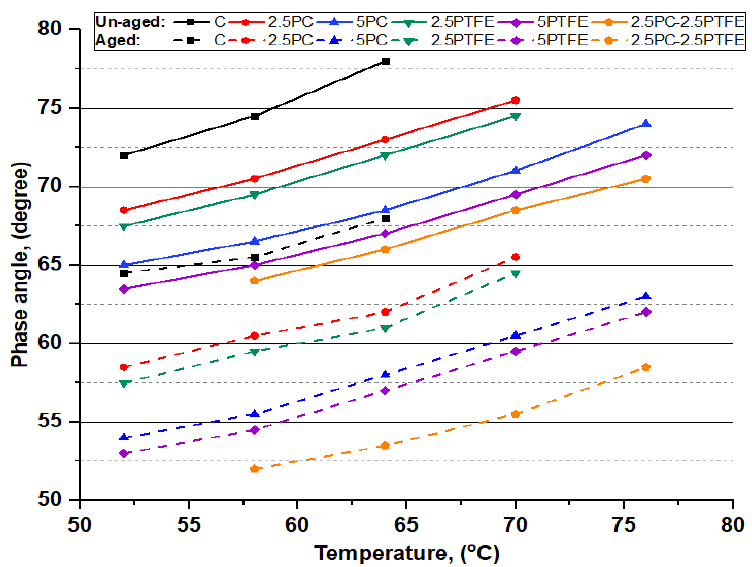
Figure 8. The phase angle (δ) and temperature relationship of binders before and after agi ng.